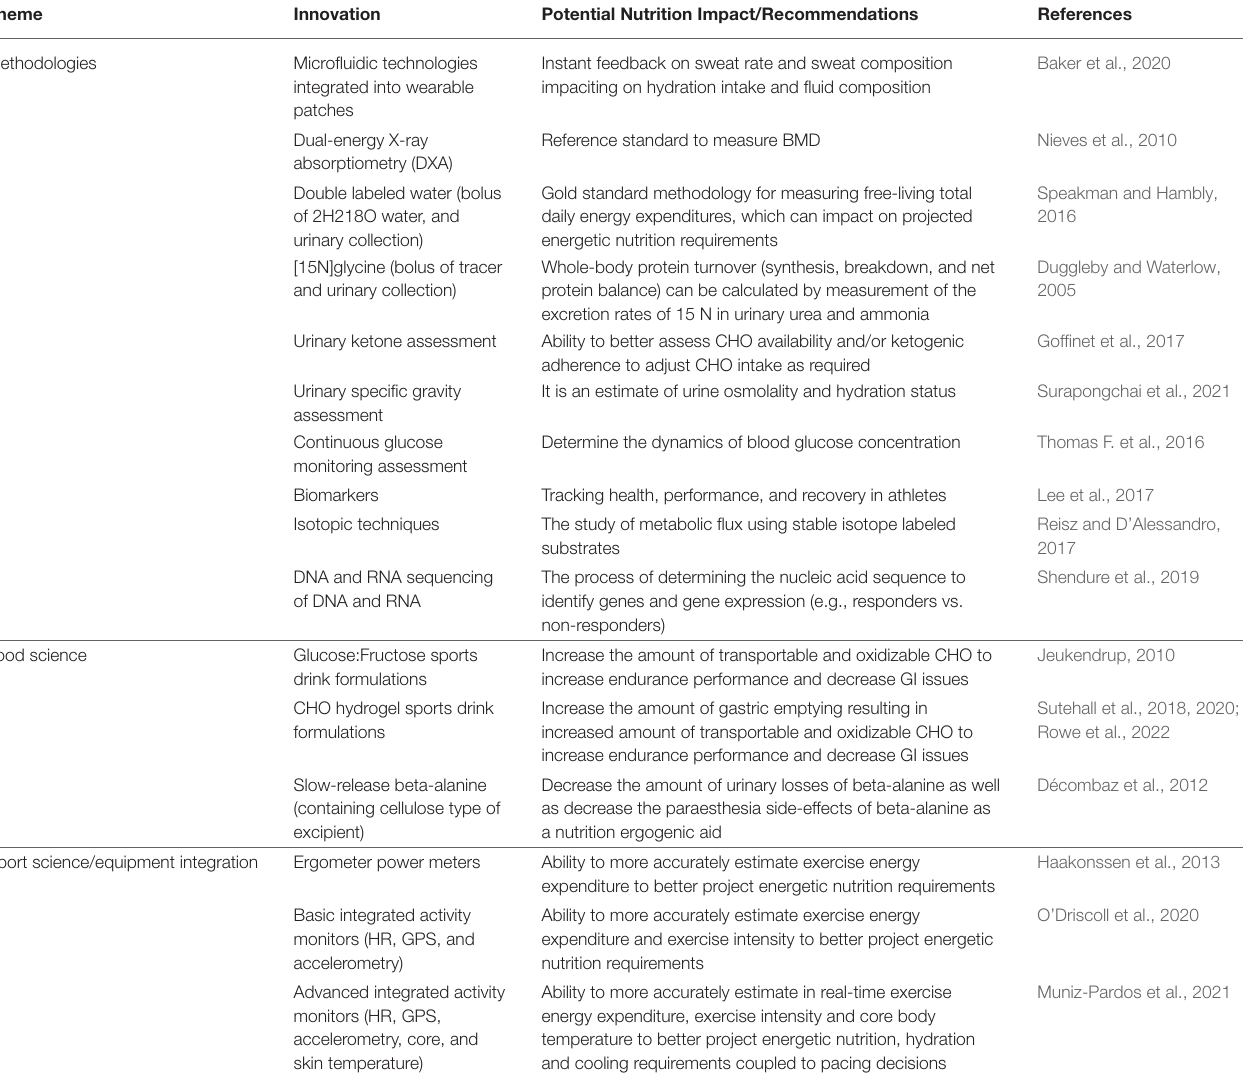
TABLE 1 | Examples of existing or potential “in field” non-invasive technologies or methodologies that may drive current or future nutrition studies, interventions, and/or